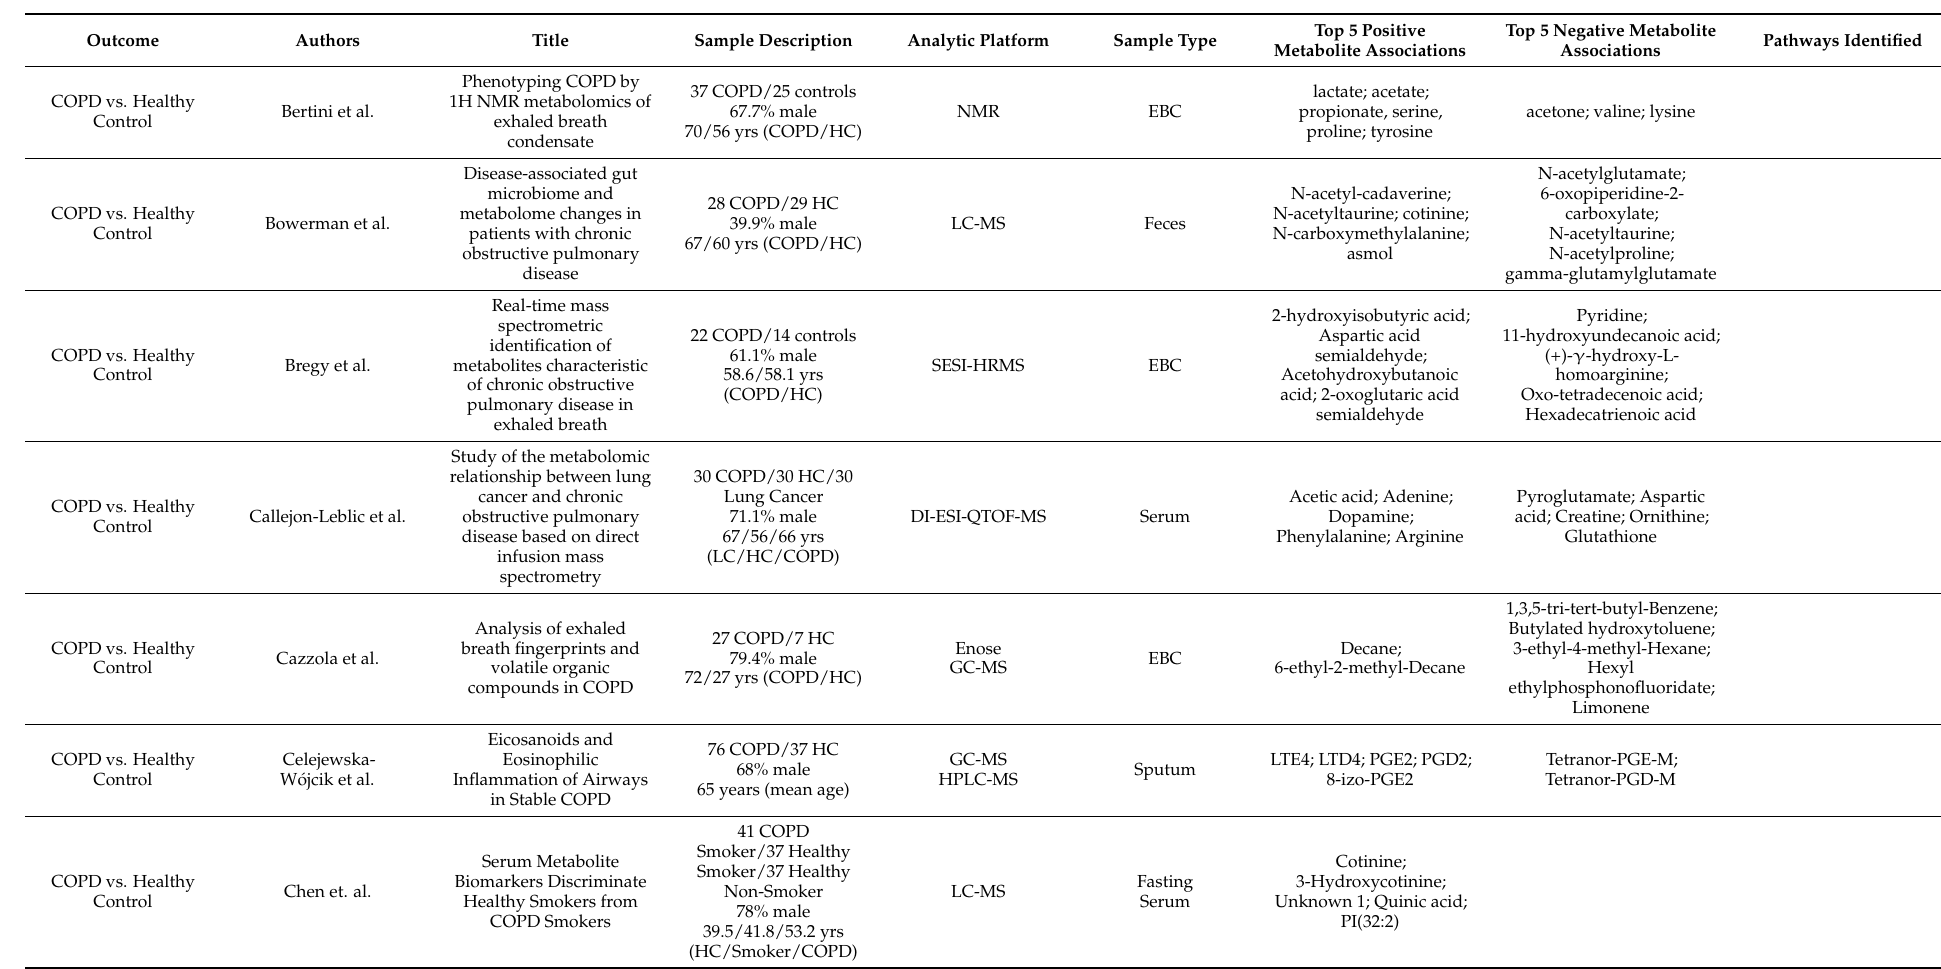
Table 1. Top 5 Positive and Negative Metabolomics Associations by COPD Outcome for Each